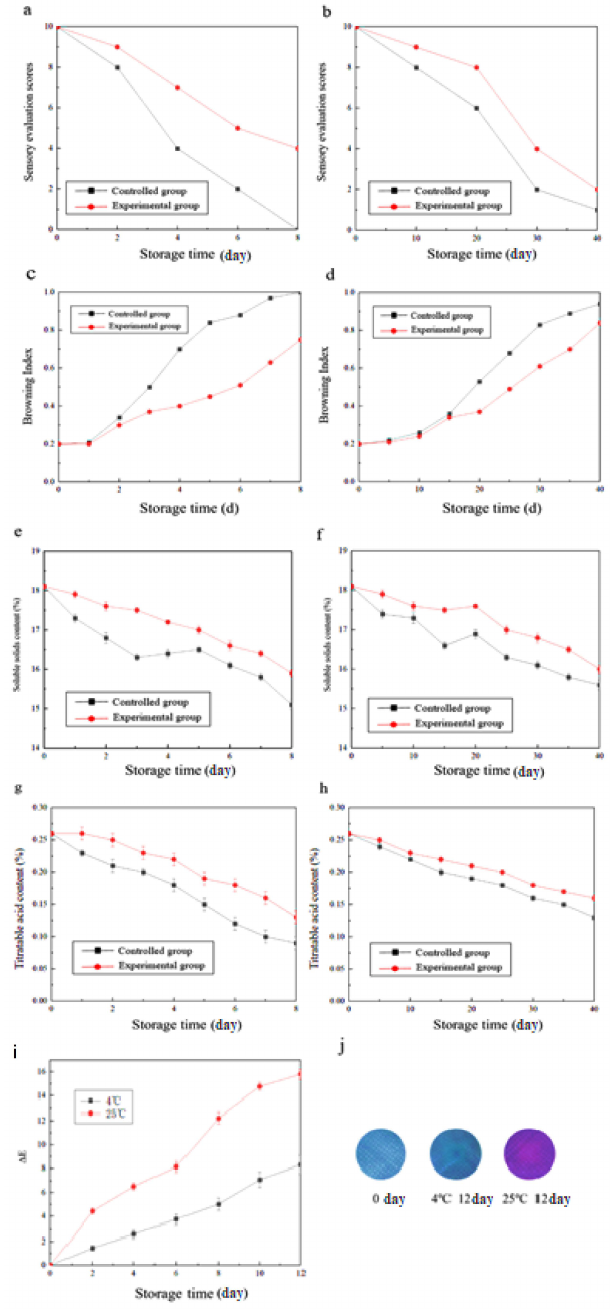
Figure 6. ( a ) Sensory evaluation score curve for storage temperature of 25 ◦ C and ( b ) storage temperature of 4 ◦ C; litchi peel browning index at ( c ) storage temperature of 25 ◦ C and ( d ) storage temperature of 4 ◦ C; Soluble solids content of the fruit at ( e ) storage temperature of 25 ◦ C and ( f ) storage temperature of 4 ◦ C; Titratable acid content of litchi fruit at ( g ) storage temperature of 25 ◦ C and ( h ) storage temperature of 4 ◦ C; ( i ) Variation in the chromatic aberration of double-layered antibacterial chromogenic materials in litchi during storage; ( j ) Change in the color of the double-layer antibacterial chromogenic materials before and after the intelligent color-rendering